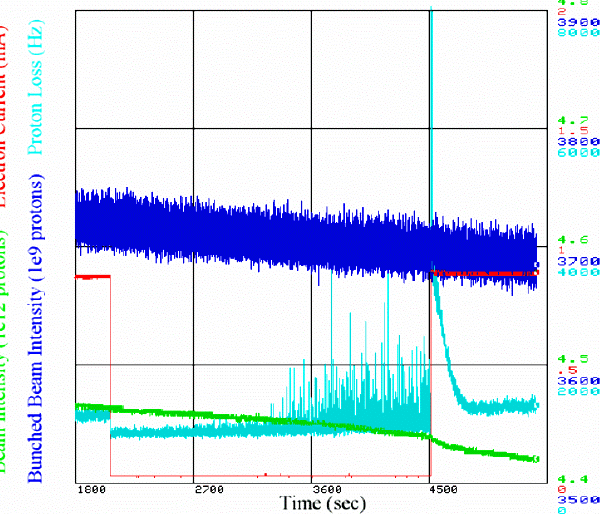
FIG. 14. (Color) Uncaptured beam accumulation and removal by TEL: the electron current was turned off and turned back on again 40 min